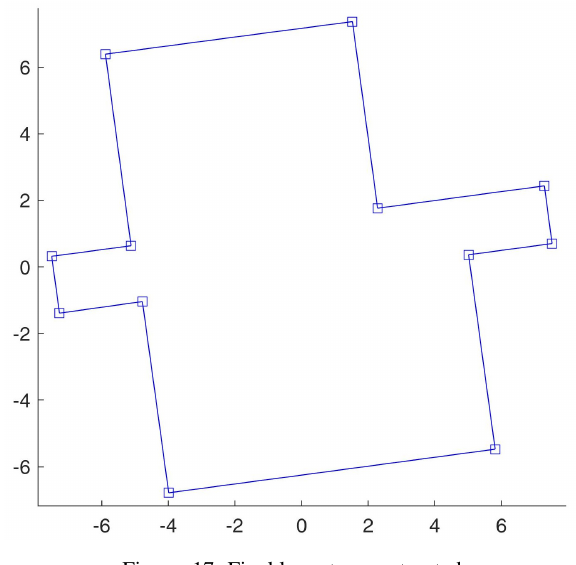
Figure 17: Final layout